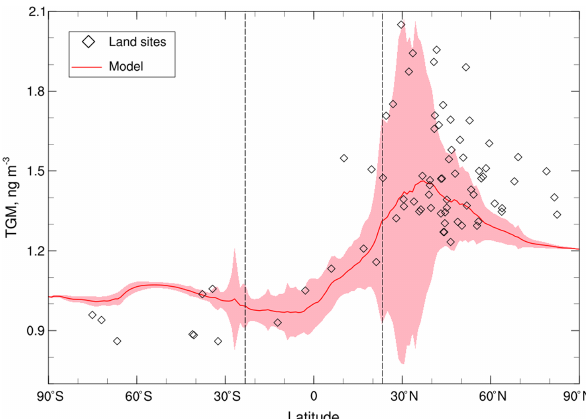
Figure 4. The latitudinal variation of surface TGM concentrations. The red line and shaded areas are the modeled means and standard deviations of 2011–2013, respectively. The two black dashed lines represent the locations of the Tropic of Capricorn and Cancer. The observations (rhombuses) at land sites only include part of the val- ues ( < 2ngm − 3 ) as shown in Fig.